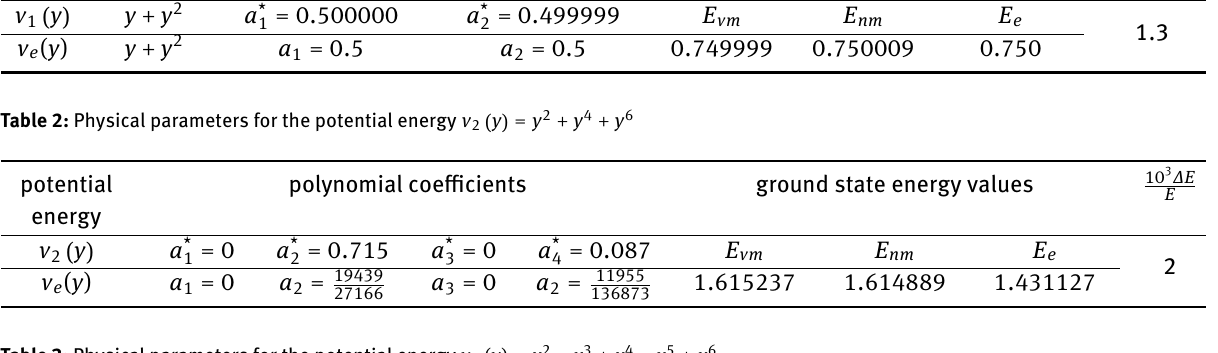
potential energy polynomial coeflcients ground state energy values